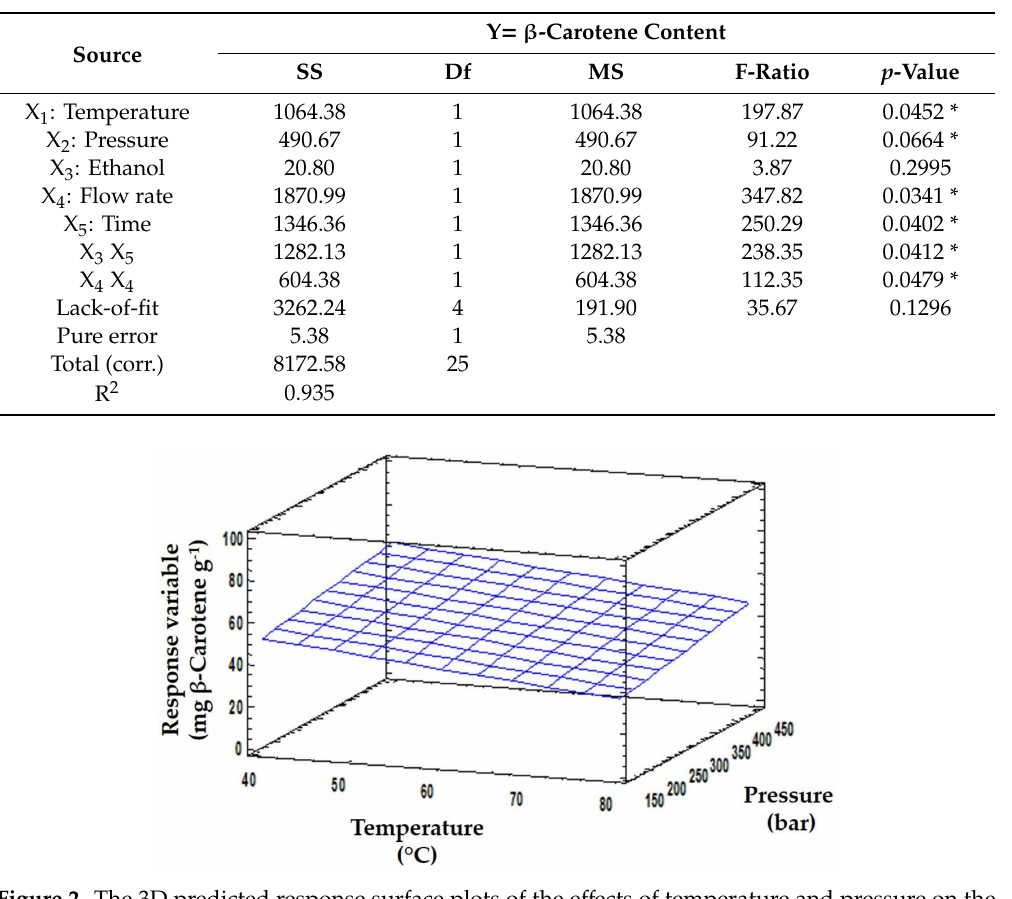
Figure 2. The 3D predicted response surface plots of the e ff ects of temperature and pressure on the β -carotene